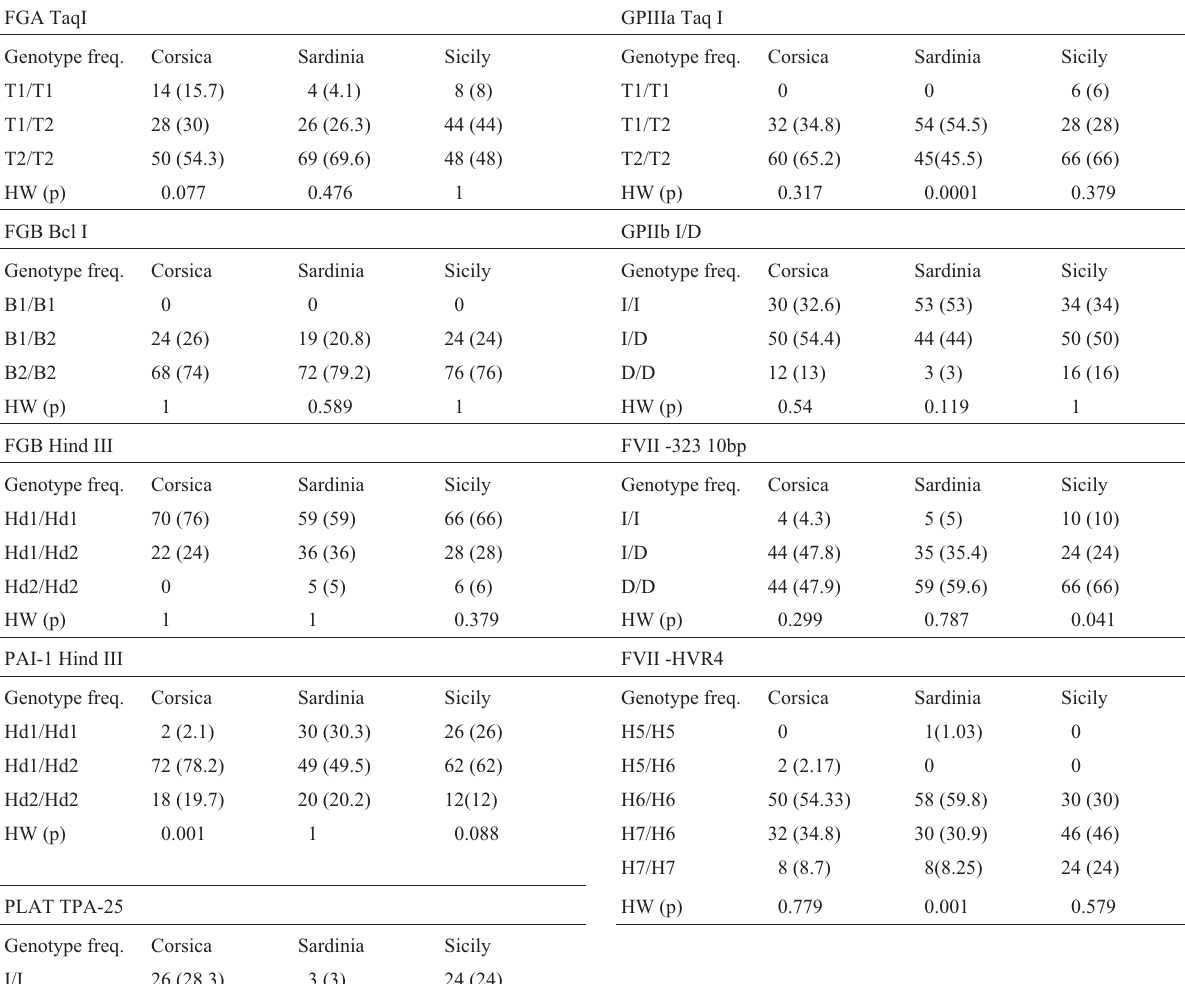
Table 2 - Genotype frequencies and probability of test for the Hardy Weinberg equilibrium at nine loci in the three Mediterranean populations. FGA TaqI GPIIIa Taq I Genotype